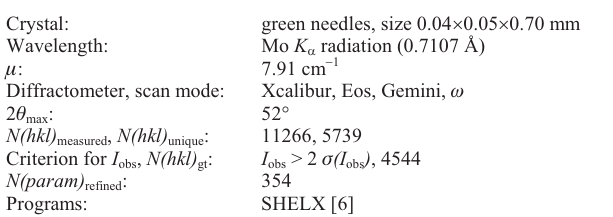
Table 1. Data collection and handling.